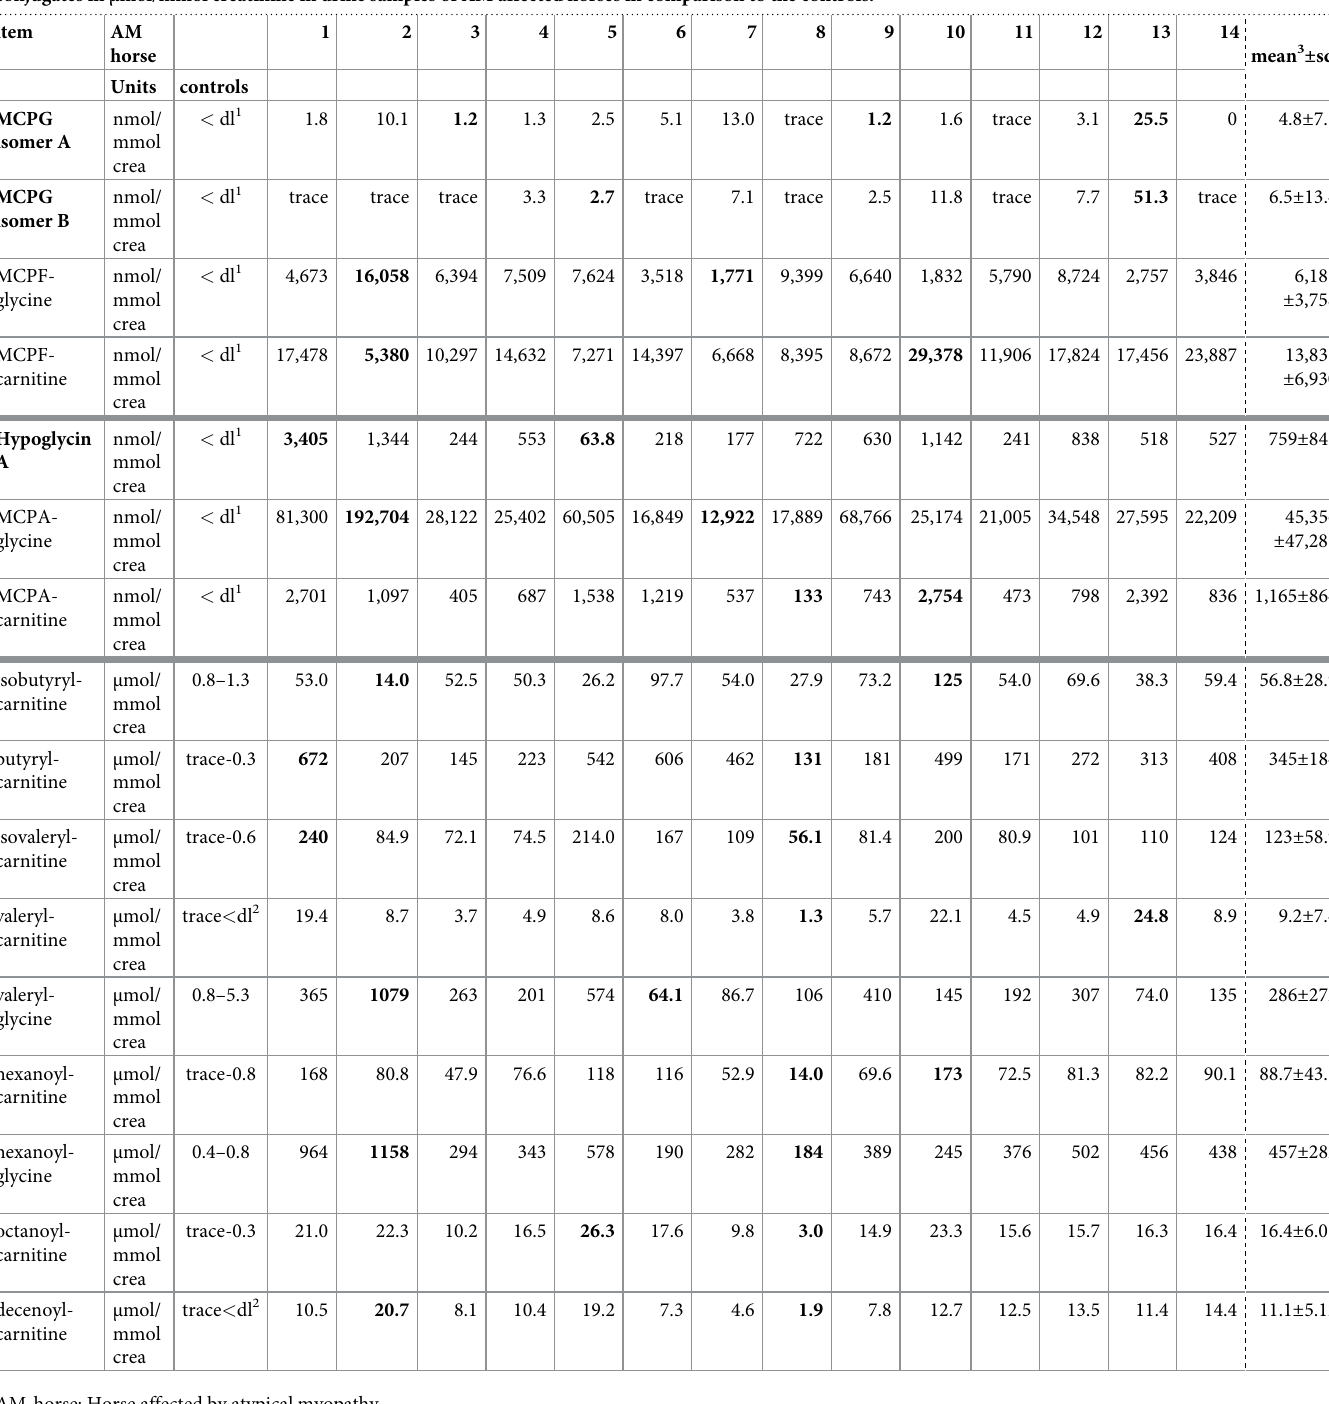
Table 5. Concentrations and means ± sd of MCPG and HGA and the corresponding metabolites in nmol/mmol creatine plus concentrations of a spectrum of acyl conjugates in μ mol/mmol creatinine in urine samples of AM affected horses in comparison to the controls.